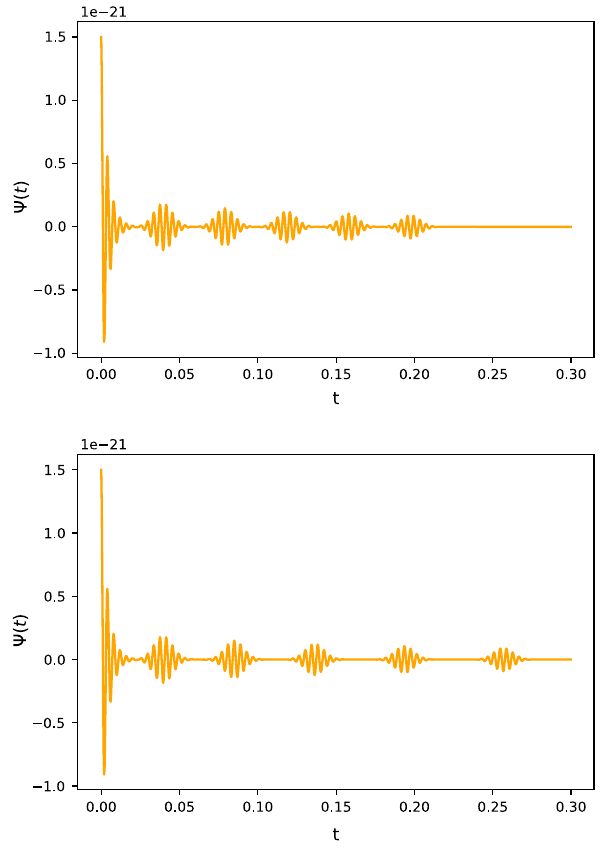
Fig. 1 GW echoes waveform templates. The horizontal axis is obser- vation time and the vertical axis is the waveform amplitude strain. The top panel shows the CIE waveform and the bottom panel shows the UIE waveform. We choose τ = 4 × 10 − 3 s, f = 250 Hz ,φ = 0 , A = 1 . 5 × 10 − 21 , A = 0 . 5 ,β = 0 . 006 s, (cid:3) t echo = 0 . 0295 s, r = 0 . 15, and t echo = 0 . 0295 s